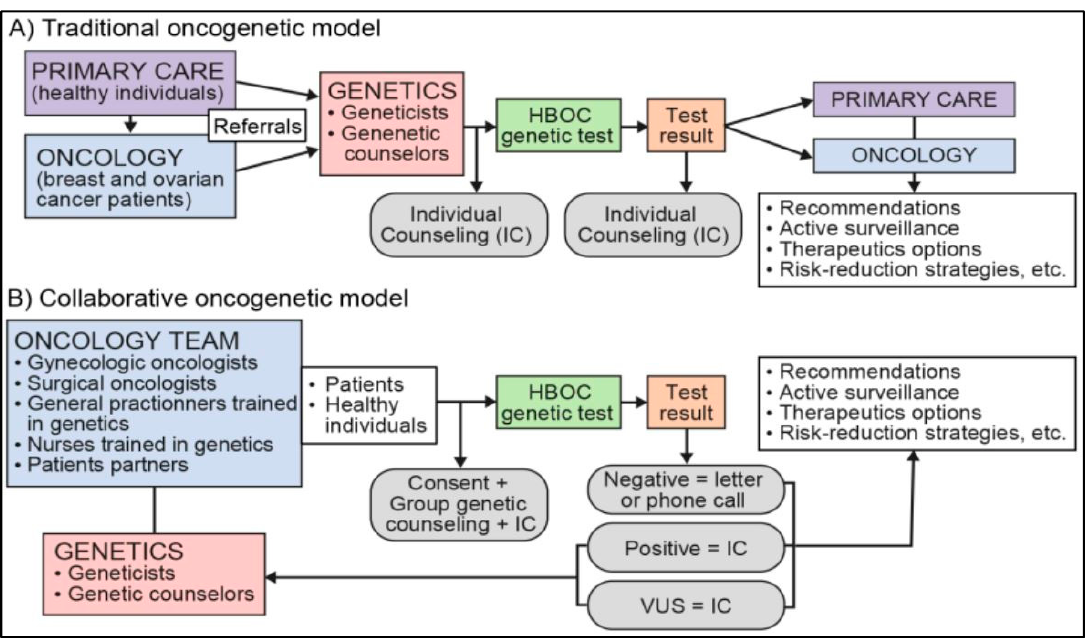
Figure 1. A Simplified Representation of Traditional and Collaborative Oncogenetic Models for Hereditary Breast and Ovarian Cancer (HBOC).